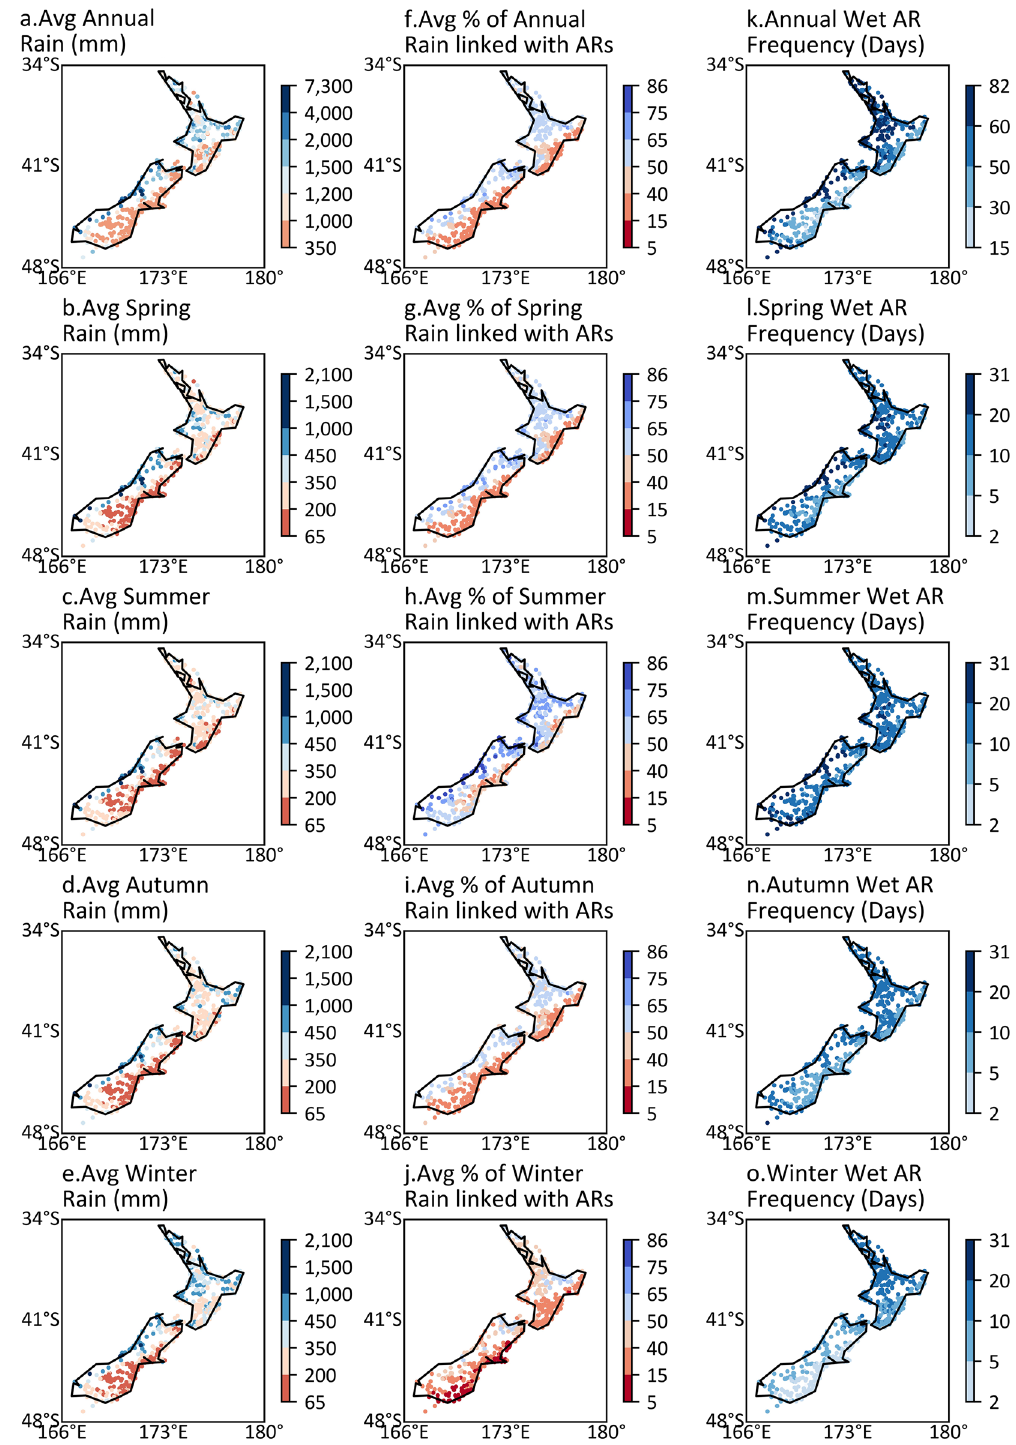
Figure 3. Maps of annual and seasonal rainfall totals, percentage of rain totals linked with ARs, and the frequency of wet AR days per year for each site. ( a – e ) Average annual and seasonal rainfall totals. ( f – j ) Annual and seasonal average percentages of rain totals linked with ARs. ( k – o ) Annual and seasonal frequency of wet AR days per year. Note that months of seasons are: Spring (SON), Summer (DJF), Autumn (MAM), Winter